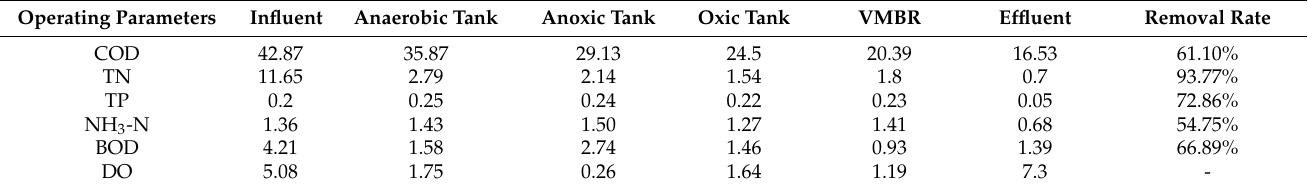
Table 1. The average of COD, TN, TP, NH 3 -N, BOD, and DO, and removal rate of every